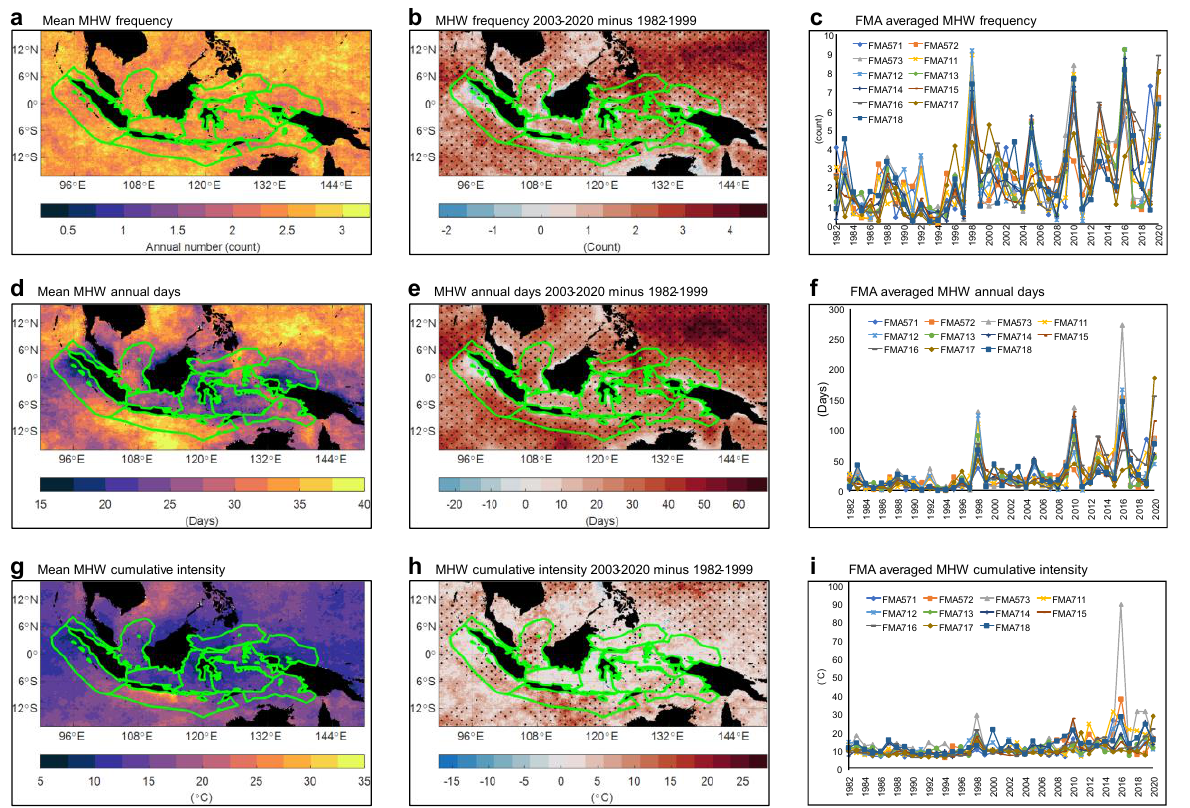
Figure 2. Average mean, trend, and FMA of marine heatwaves metrics: frequency ( a – c ), annual days ( d – f ), and cumulative intensity ( g – i ). Table 1. Mean and trend of MHWs metrics: cumulative intensity, MHW days, and annual frequency. Red shading indicates the order of the highest trend values in each metric. Cumulative Intensity MHW Days Annual Frequency FMA Mean Trend ( ◦ C/Decade) Trend